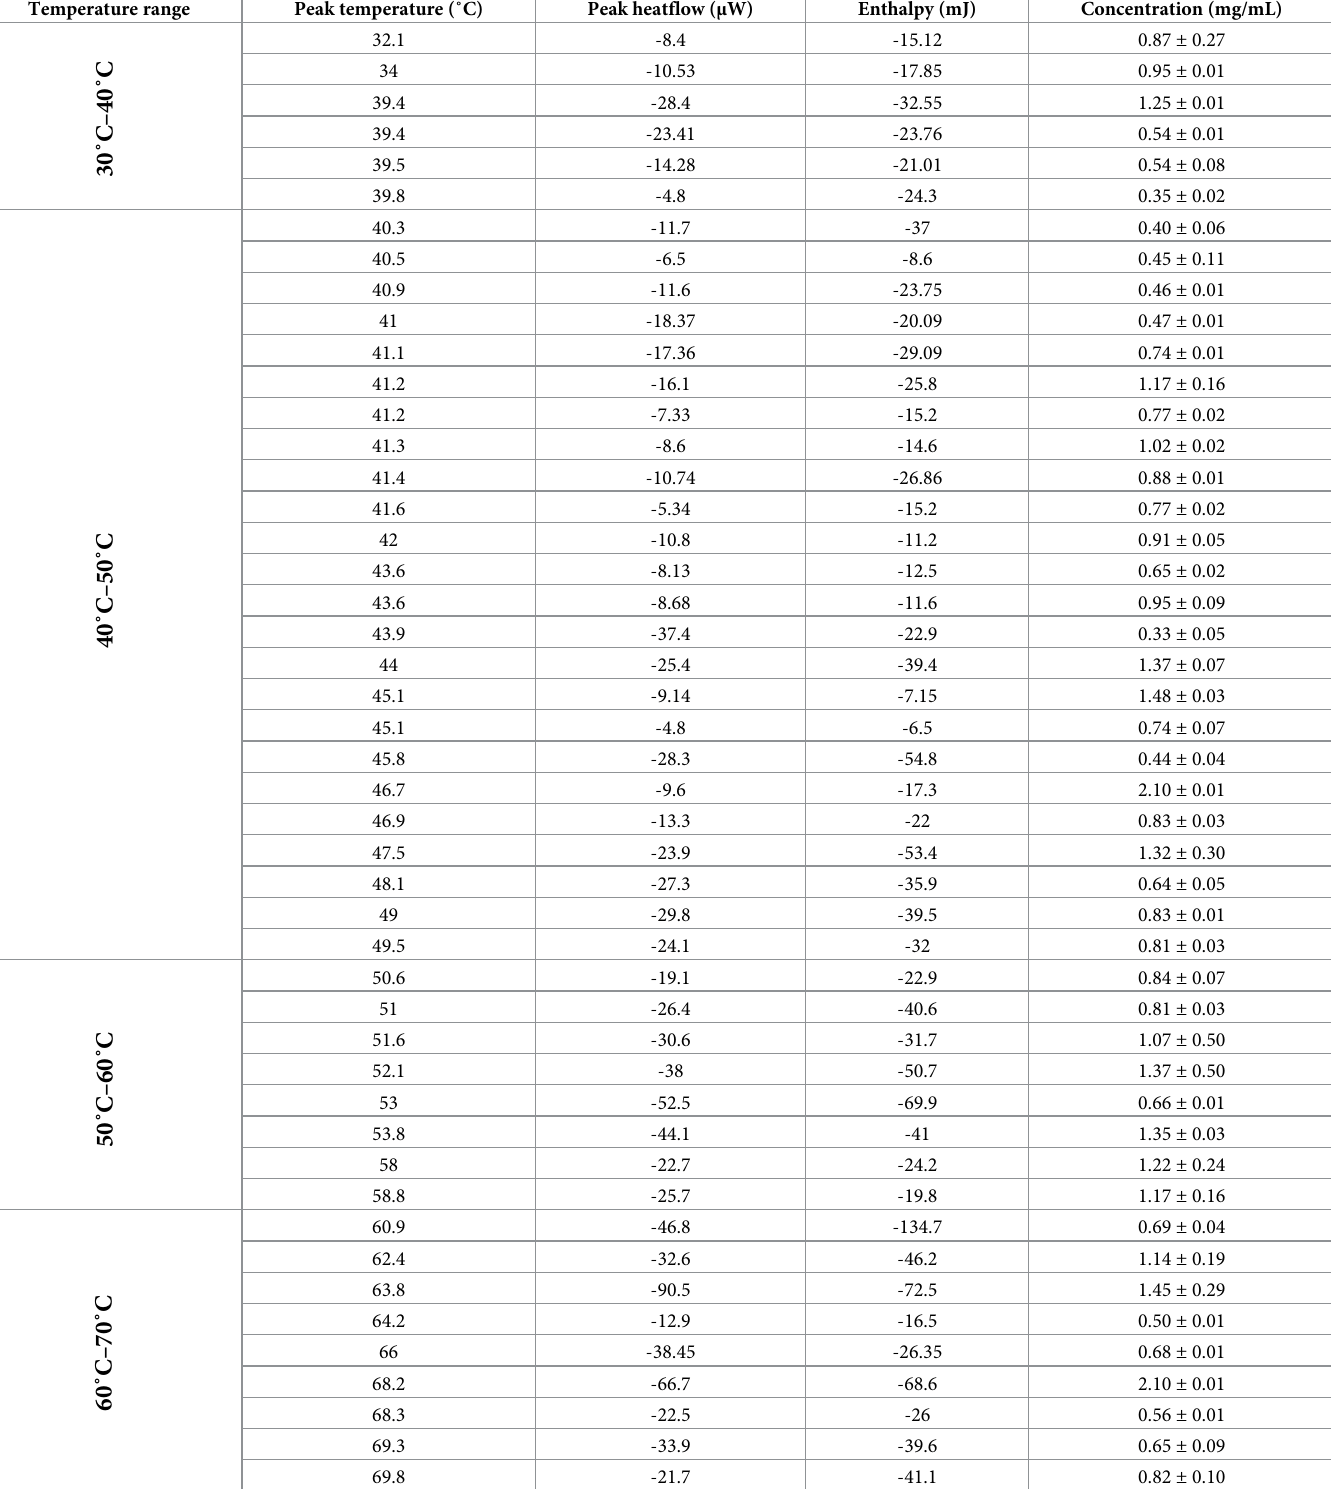
Table 1. Parameters of thermal profiles obtained from stimulated saliva samples. Temperature